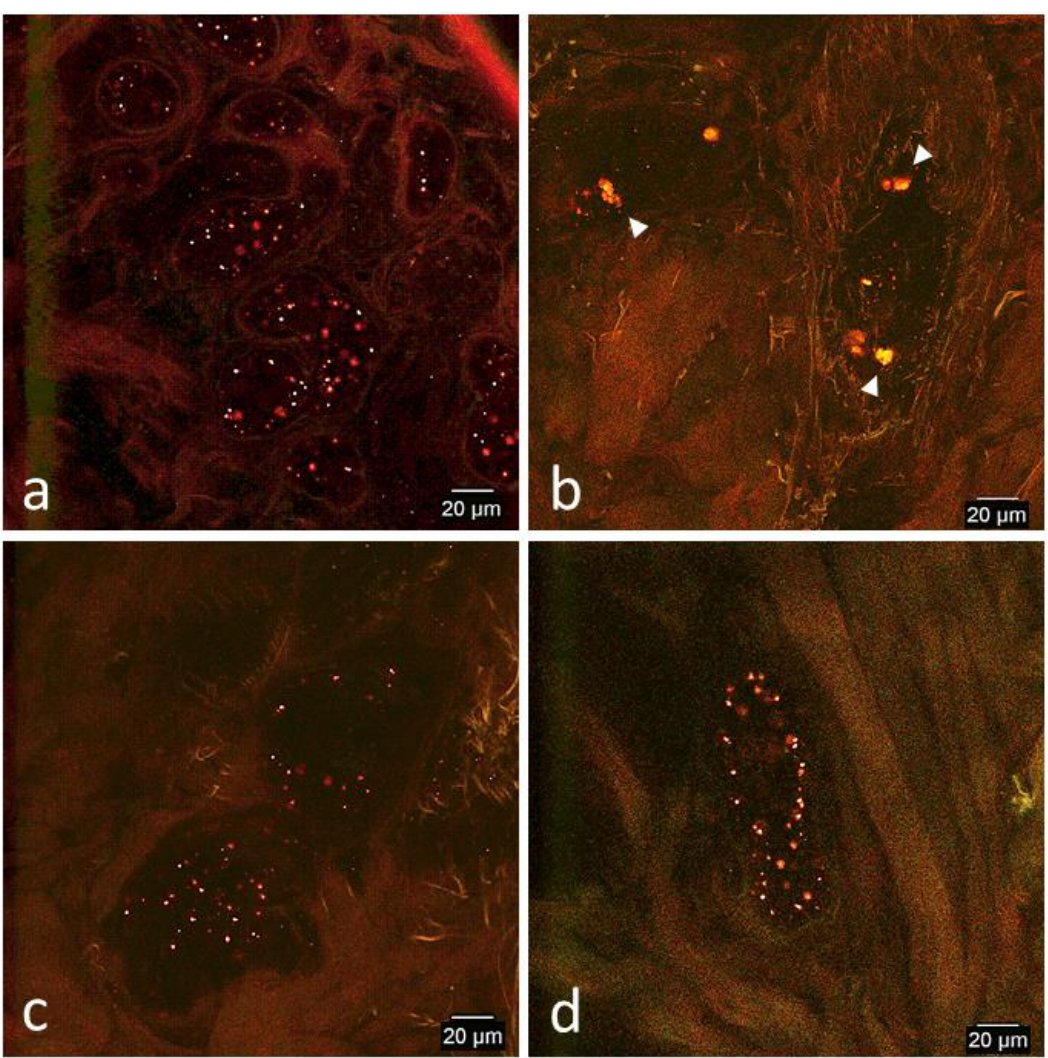
Figure 5. Representative confocal microscopy images of biopsies of limb and thoracic wounds and contralateral non-wounded skin on day 2. ( a ) Wounded limb, ( b ) non-wounded limb, ( c ) wounded thorax, and ( d ) non-wounded thorax. Images were selected from either horse based on best representation of patterns typical fluorescent signal patterns of both horses. Images have been selectively enhanced for purposes of demonstrating signal variation. There was slightly more homing to limb wounds ( a ) than the non-wounded limb site ( b ). There was no difference in homing between the thoracic wounds ( c ) and non-wounded thoracic sites ( d ). Signal was red and green and located within the vasculature and occasionally along the endothelium ( d ) of both wounded and non-wounded biopsies. Cell-like structures measuring 8-10 um with colocalization of red and green signal were occasionally detected adjacent to the vasculature in wounded and non-wounded limb biopsies of horse 1 (arrowheads, b ).